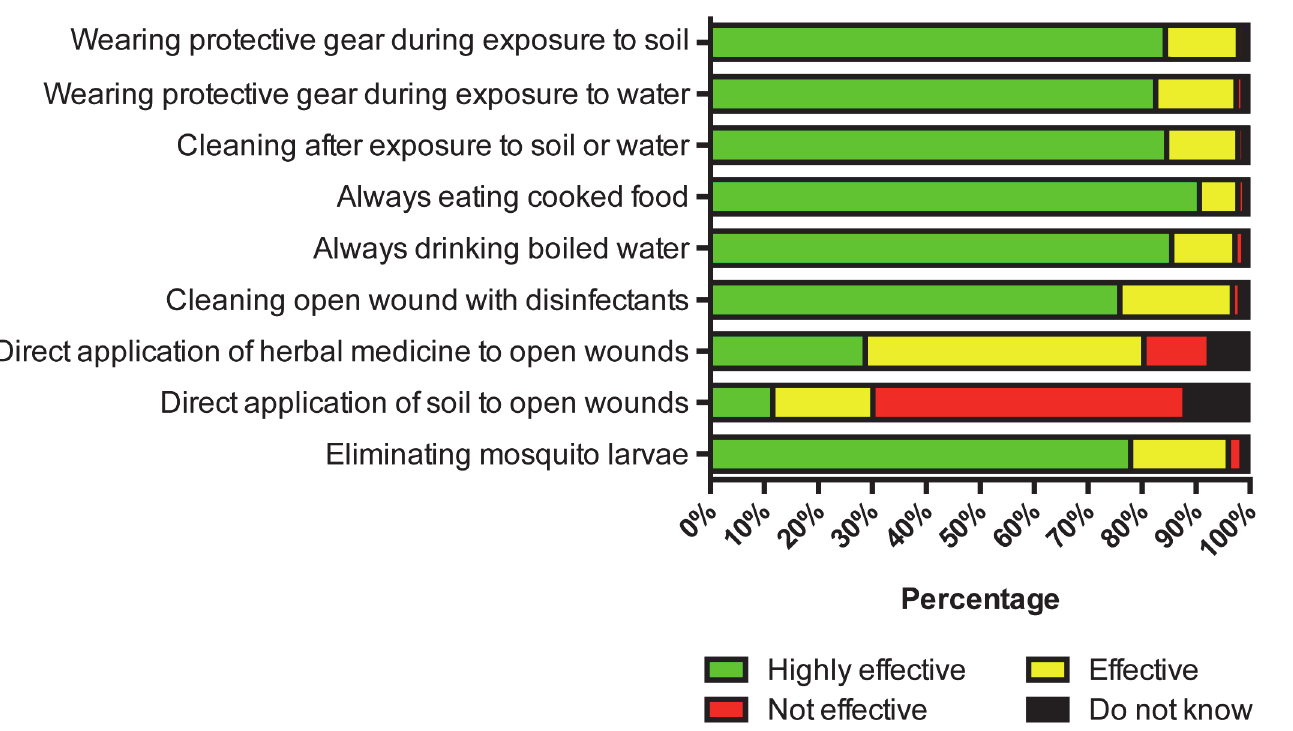
Fig 3. Knowledge about preventive measures for common infectious diseases in Thailand (n = 4,203).